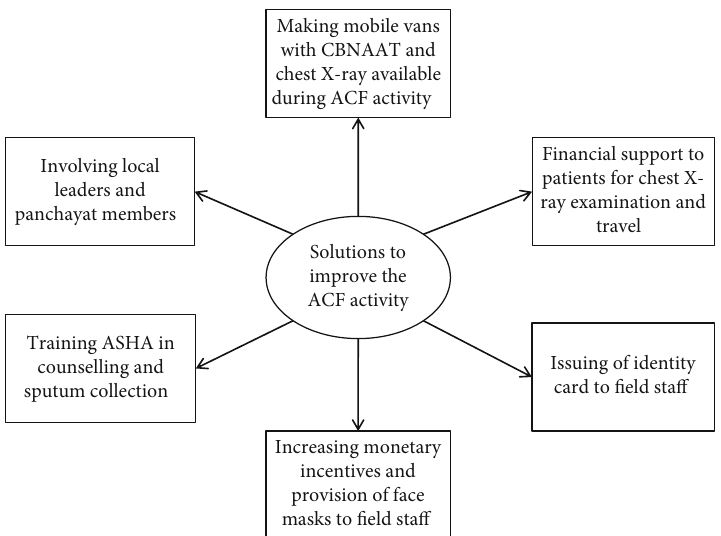
Figure 4: Solutions to improve ACF activity as perceived by health care providers and